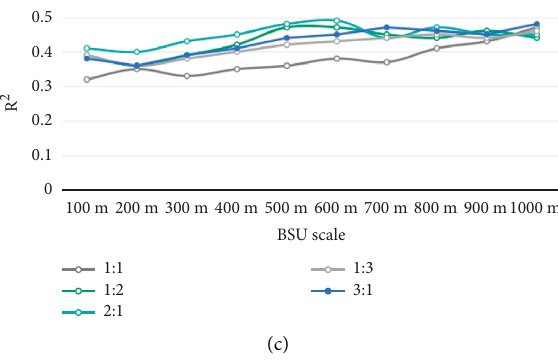
Figure 14: R 2 of GWR model. (a) R 2 of GWR-TE. (b) R 2 of GWR-TS. (c) R 2 of GWR-TC. Table 4: Judgment matrix filled in by expert A.